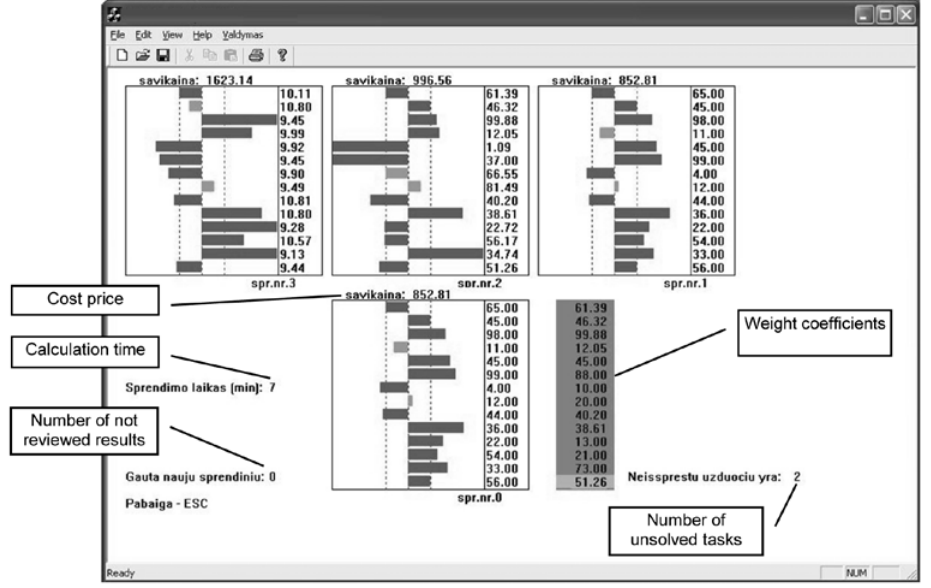
Fig. 1. Graphic interface of decision support